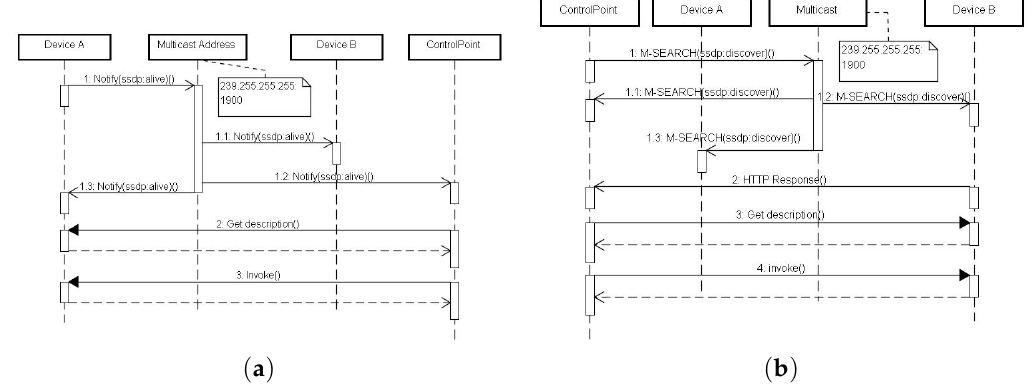
Figure 5. Baseline service management scheme: ( a ) UPnP presence and absence announcement; ( b ) UPnP proactive